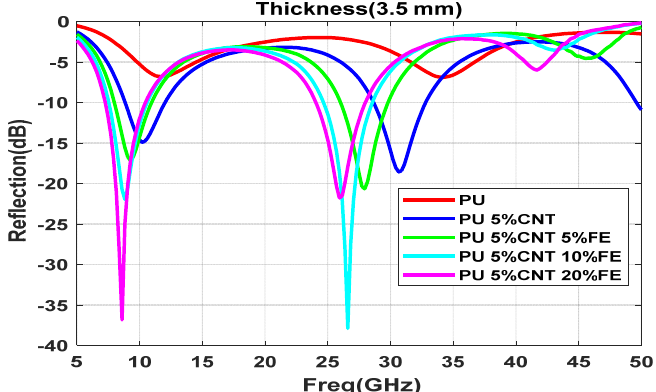
Figure 17. Reflection loss for different concentrations of Fe at 3.5 mm thickness.